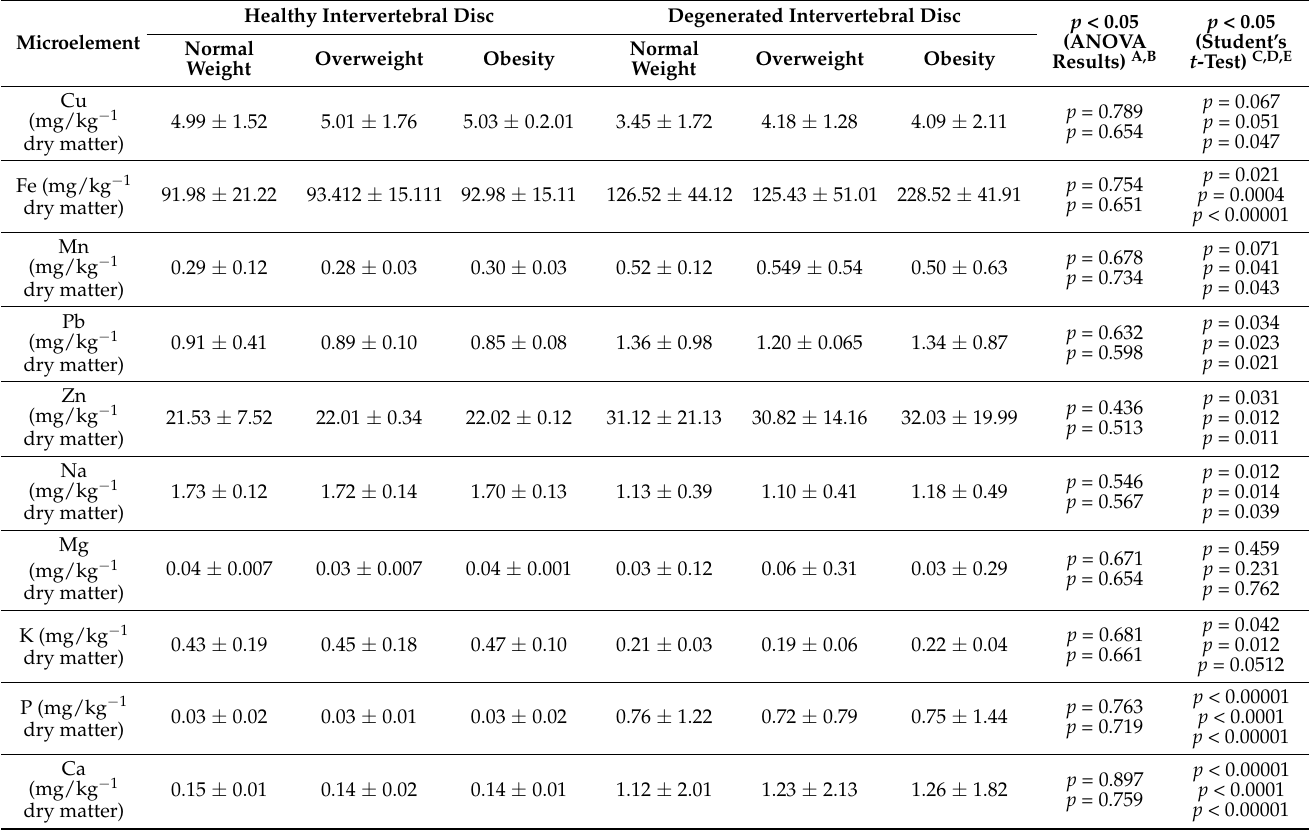
Table 5. Concentrations of selected elements in the study and control groups depending on BMI